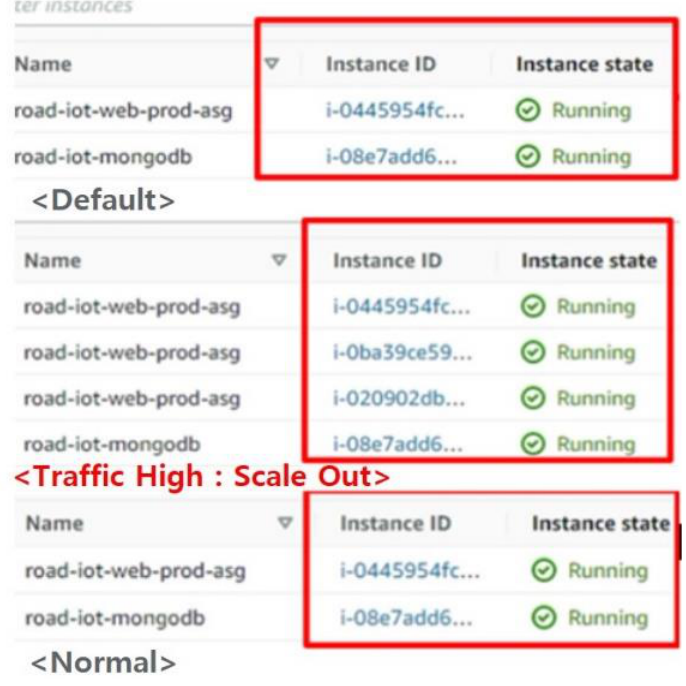
Figure 8. Virtualization server scale-out.